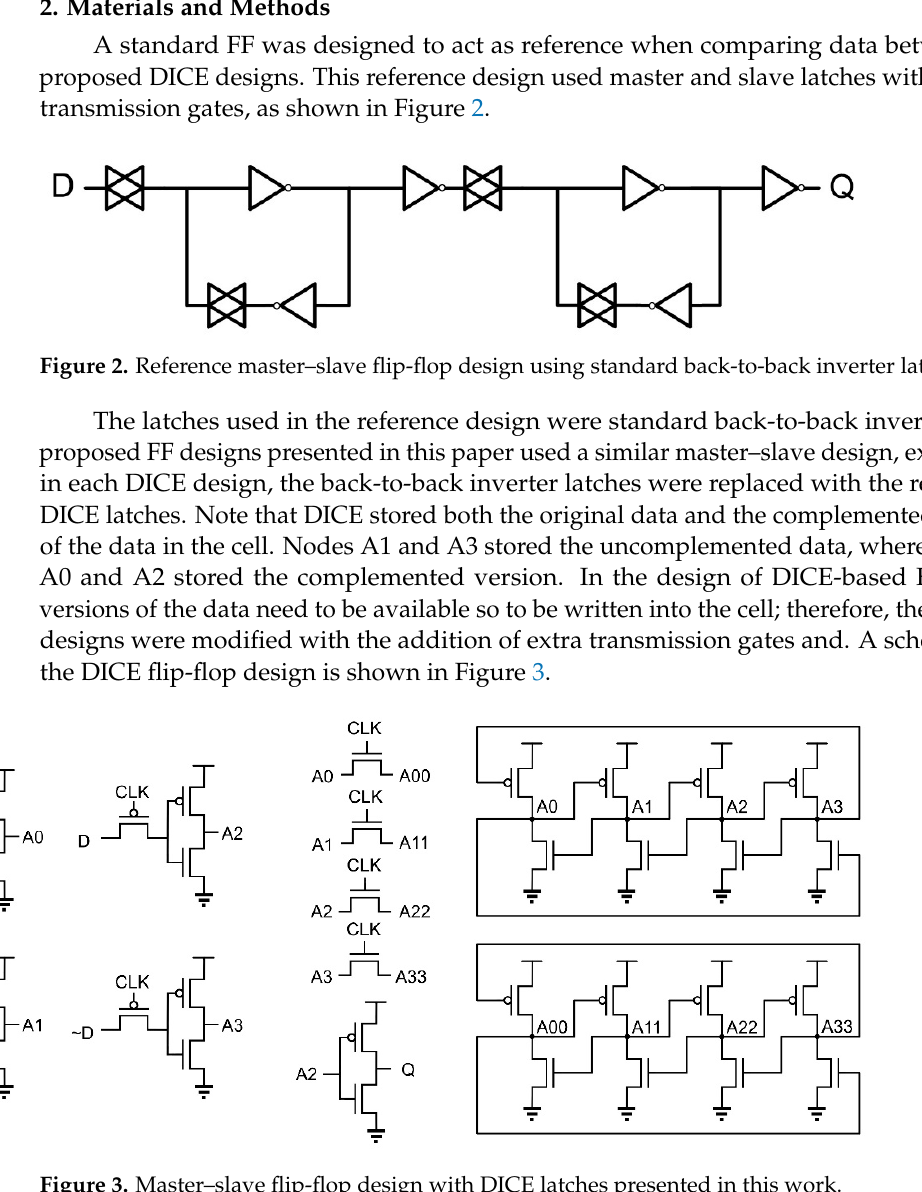
Figure 3. Master–slave flip-flop design with DICE latches presented in this work.